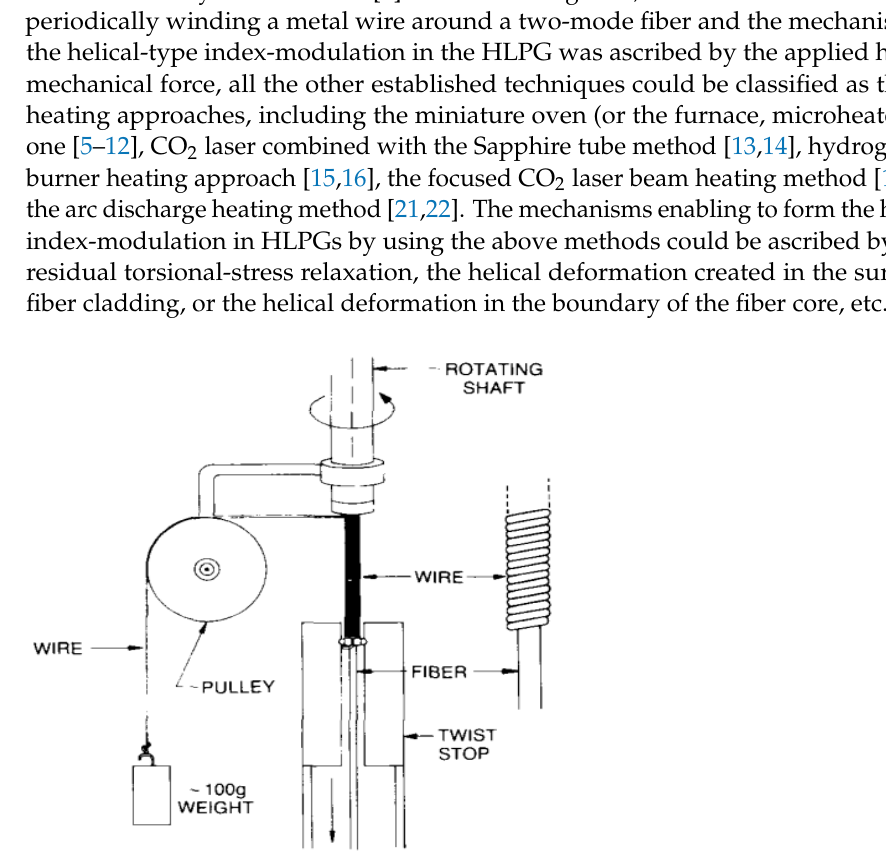
Figure 5. Fabrication of the HLPG by winding a metal wire around the fiber. © [2021] IEEE. Reprinted, with permission, from Ref. [3].